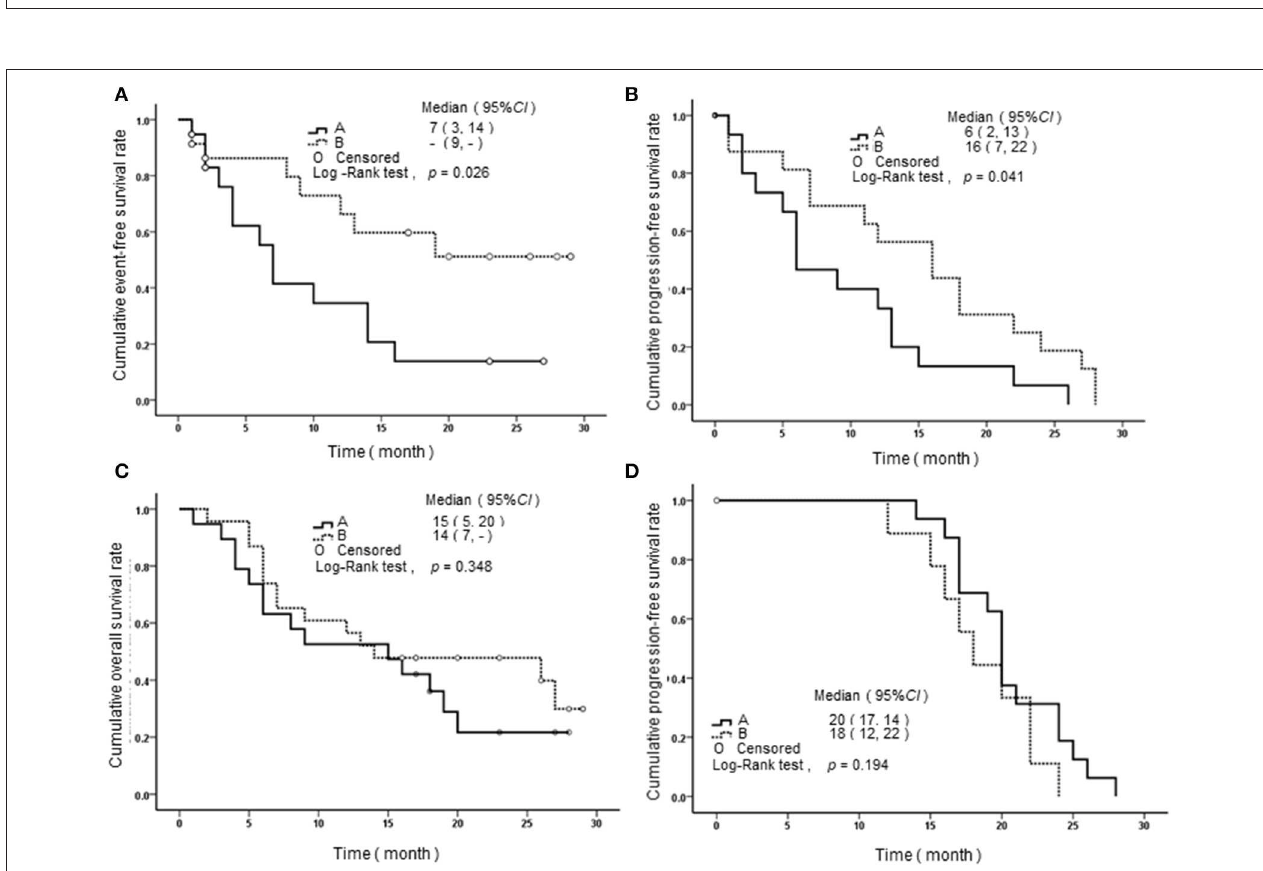
FIGURE 5 | Survival curves of AML patients with different SPRED1 mRNA expression at diagnosis. (A) Event-free survival curves of patients with non-APL; (B) progression-free survival curves of patients with non-APL; (C) overall survival curves of patients with non-APL; (D) progression-Free survival curves of patients with APL. A line, fold change in SPRED1 mRNA < 0.03; B line, fold change in SPRED1 mRNA ≥ 0.03 (log-rank test).